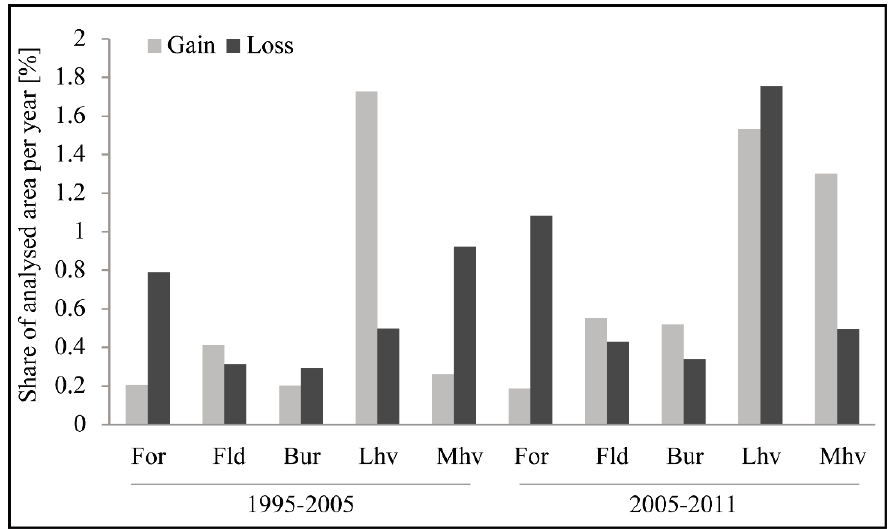
Figure 2. Gain and loss for each LC class as percentage of analysed area per year from 1995–2005 ( left ) and 2005–2011 ( right ). LC classes: For = Forest, Fld = Flooded vegetation, Bur = Burnt plots, Lhv = Low-height vegetation, Mhv = Medium-height vegetation.